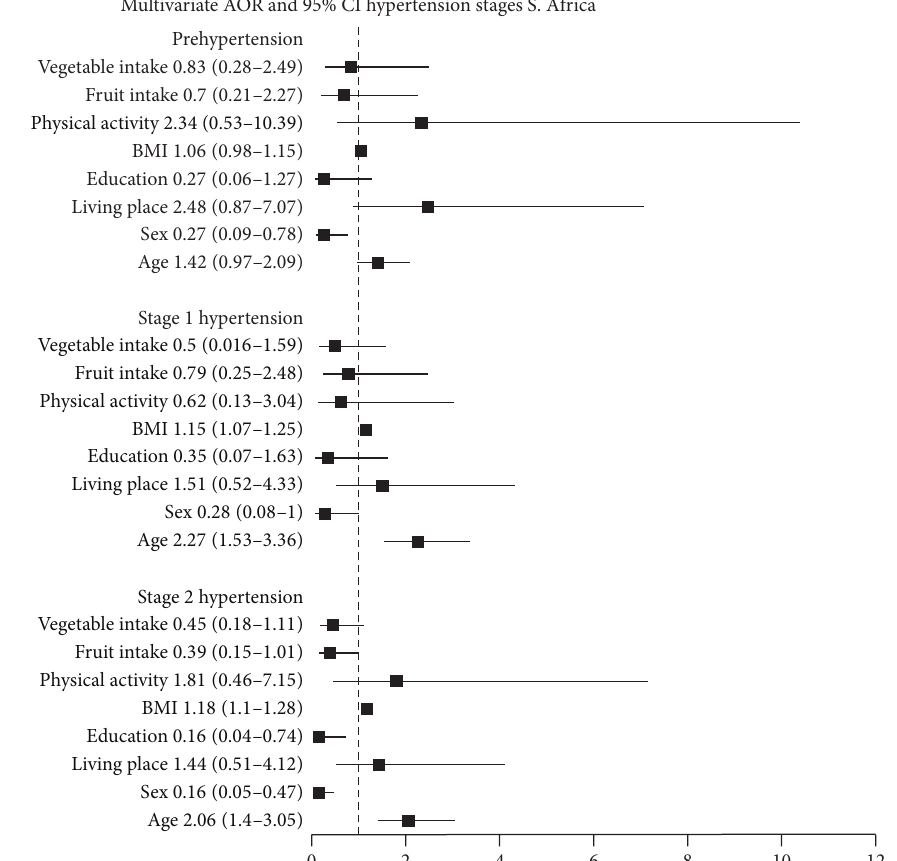
Figure 2: Adjusted odds ratios and 95% confidence intervals for stages of hypertension, South